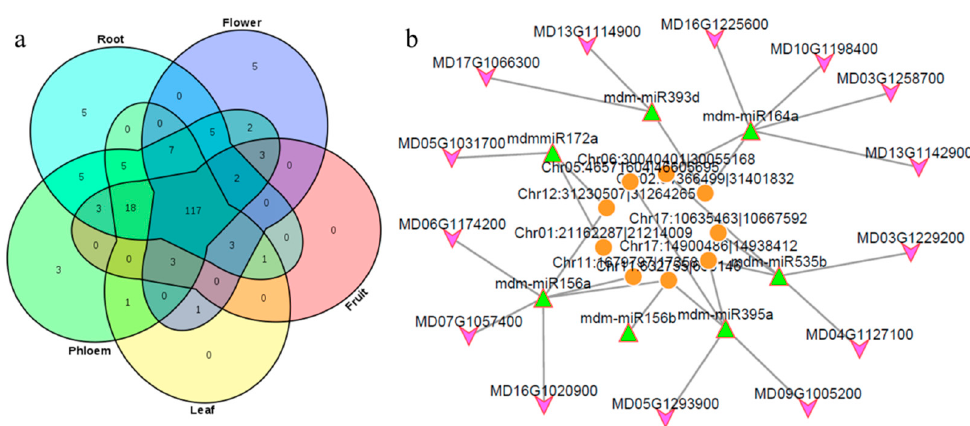
Figure 6. Tissue specific characteristics and function prediction of circRNAs-miRNAs-mRNA: ( a ) Number of the miRNA predicated which had target sites in circRNA identified in five tissues. ( b ) Network predicted of circRNAs-miRNAs-mRNAs in apple (orange circle: circRNAs; green triangle: mdm-miRNAs; purple arrow: mRNAs).